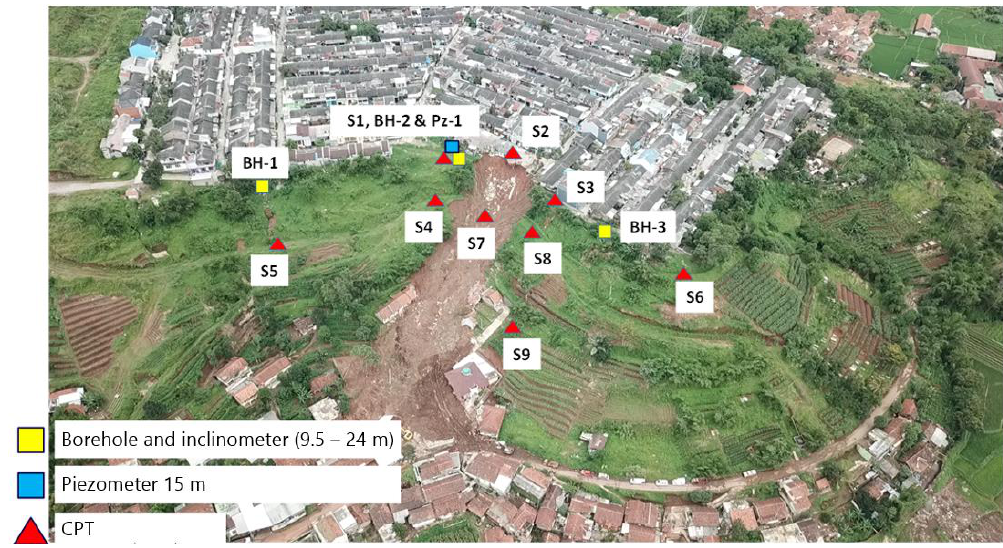
Figure 5. Borehole (BH-1 to BH-3), piezometer (Pz-1), and CPT (S1 to S9) locations.